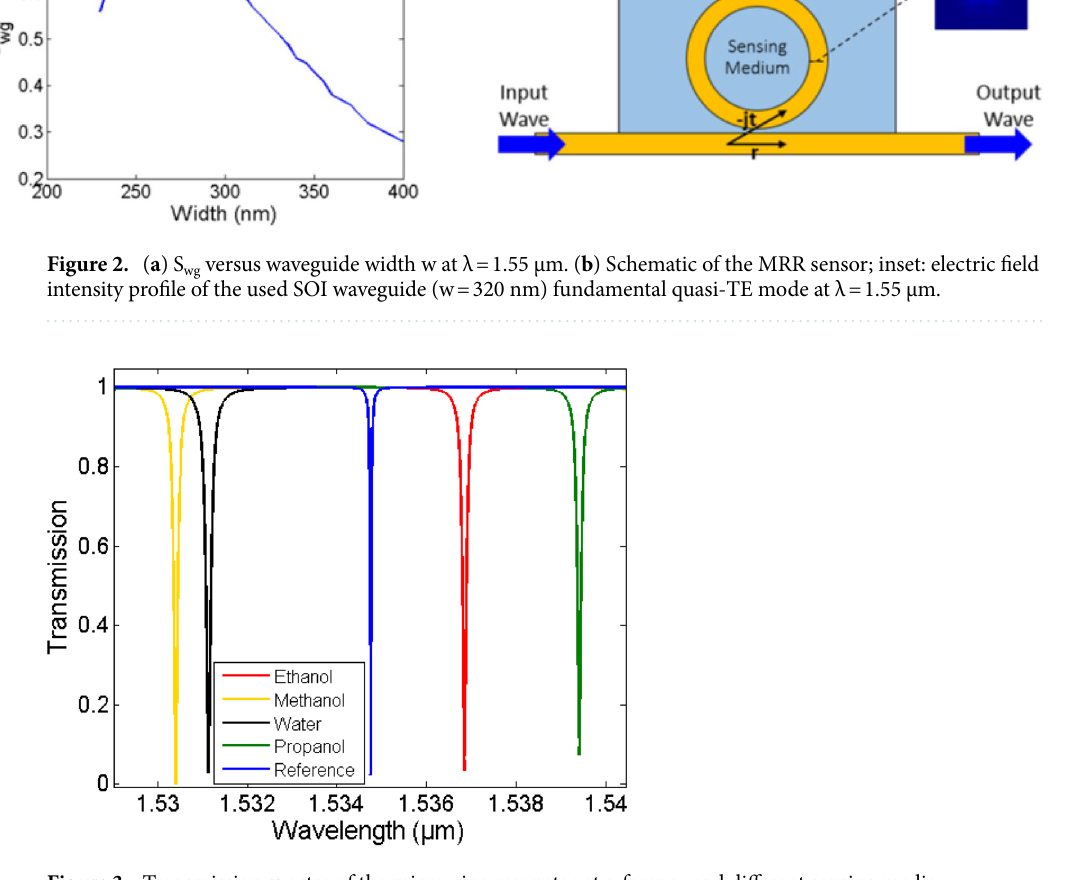
Figure 3. Transmission spectra of the micro-ring resonator at reference and different sensing